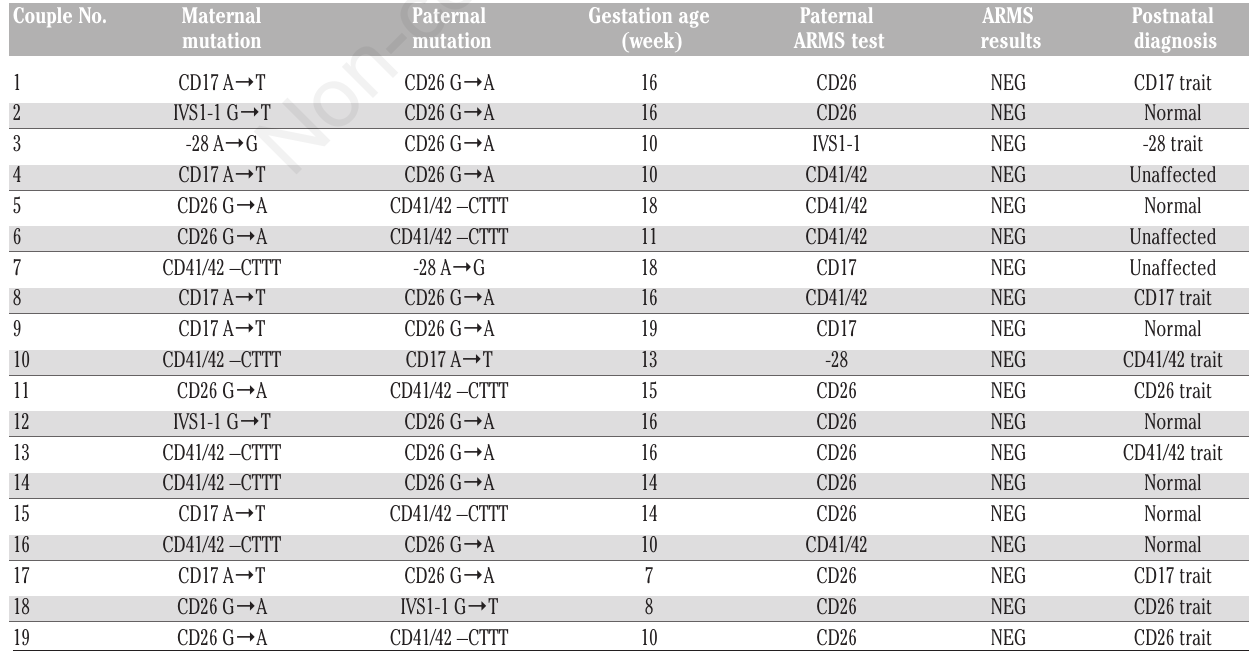
Table 2. Negative cases of the NIPST using modified ARMS RT- PCR for the detection of PIBTM in maternal plasma cell-free DNA in the at-risk couples. Couple No. Maternal Paternal Gestation age Paternal ARMS Postnatal mutation mutation (week) ARMS test results diagnosis